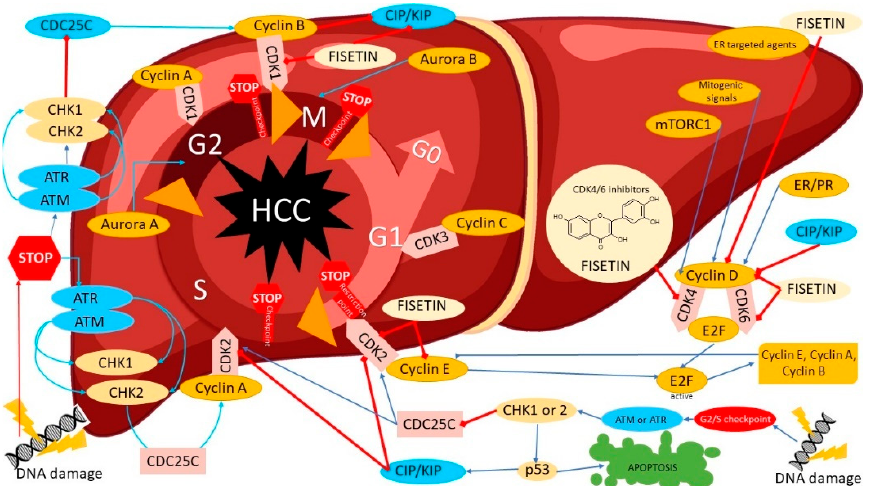
Figure 2. The potential mechanisms of cell-cycle inhibition of liver cancer cells (hepatocellular cancer, HCC) by modulation of several regulatory proteins under the influence of fisetin such as CDK4, Cyclin-dependent kinase 4; CDK6, Cyclin-dependent kinase 6; Cyclin D; CDK2, Cyclin-dependent kinase 2; CIP/KIP, the Cip/Kip family, namely, p21(Cip1), p27(Kip1) and p57(Kip2); CDK1, Cyclin-dependent kinase 1; CDC25C, M-phase inducer phosphatase 3; CDK3, Cyclin-dependent kinase 3; CHK1, Checkpoint kinase 1; CHK2, Checkpoint kinase 2; ATM, serine/threonine kinase; ATR, Serine/threonine-protein kinase; AuroraB, Aurora kinase B; AuroraA, Aurora kinase A; E2F, E2 transcription factors.